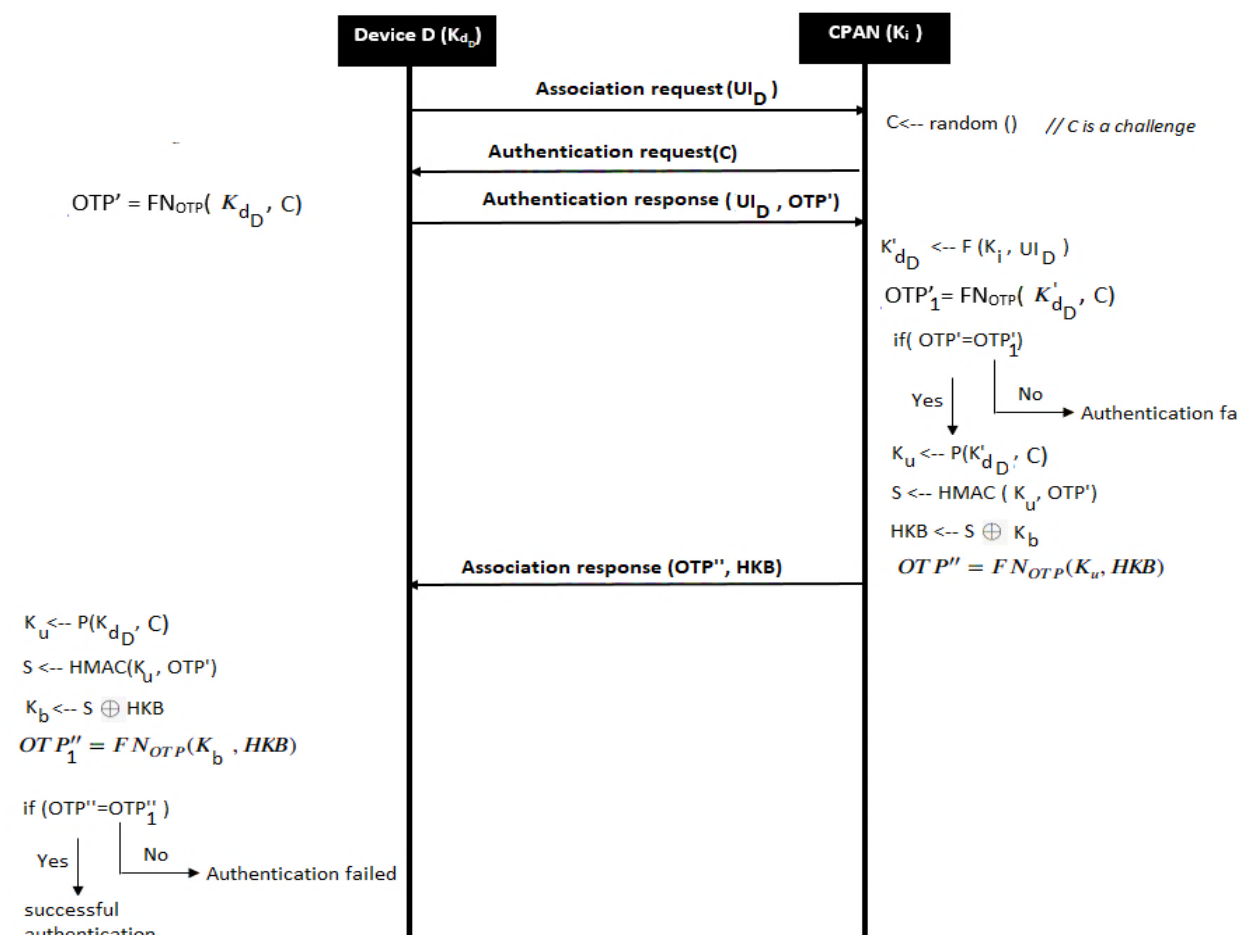
Figure 2. Our proposed protocol